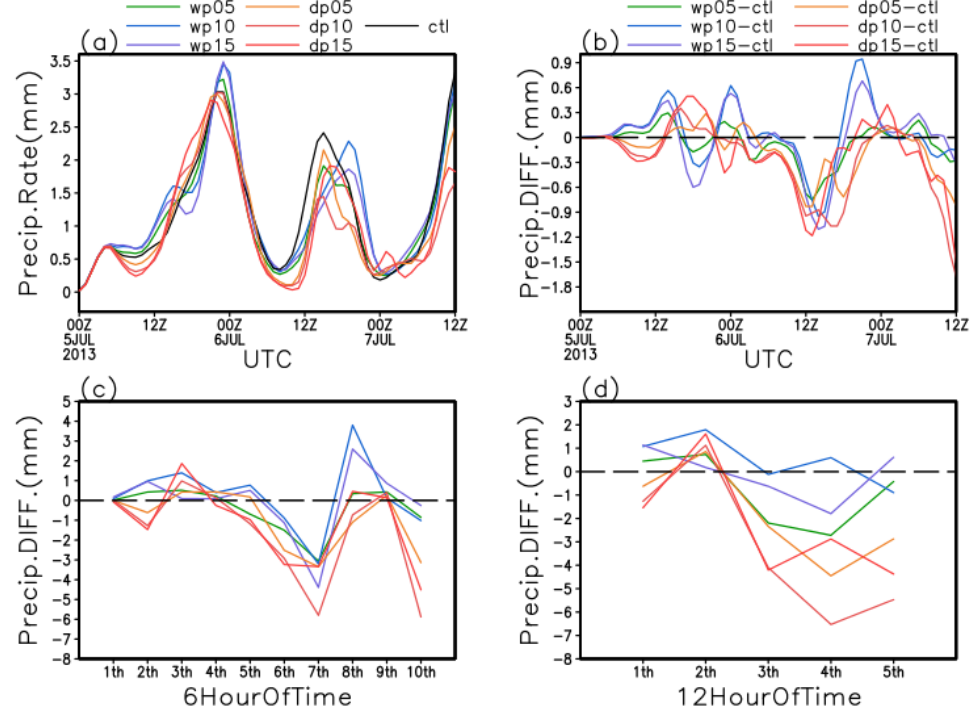
Figure 15. ( a ) The precipitation rate (units: mm); ( b ) Differences in precipitation rate (units: mm), and differences of 6-h ( c ) and 12-h ( d ) area-averaged accumulated precipitation between sensitivity experiments and the CTL experiment (units: mm).